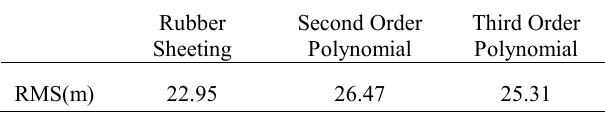
Table 1. Accuracy comparison of orthorectification models